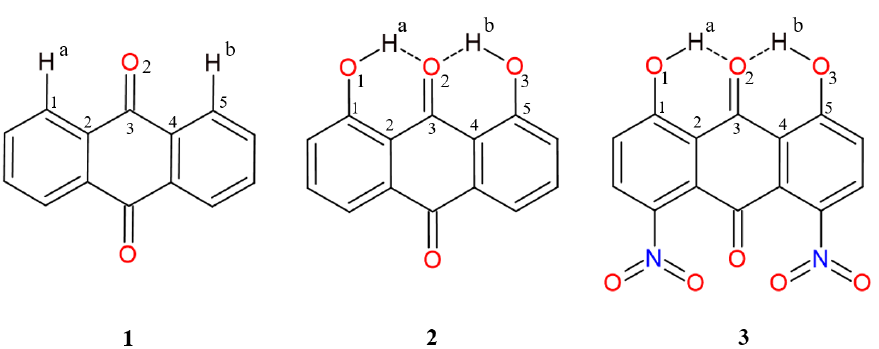
Figure 1. The structures of the studied anthraquinones: 9,10-anthraquinone ( 1 ), 1,8-dihydroxy-9,10- anthraquinone ( 2 ) and 1,8-dinitro-4,5-dihydroxy-anthraquinone ( 3 ) with atoms numbering scheme prepared for the study. Only atoms of interest are marked. The atom coloring scheme is as follows: grey—carbon, red—oxygen, blue—nitrogen and white—hydrogen. The dotted line indicates the presence of intramolecular hydrogen